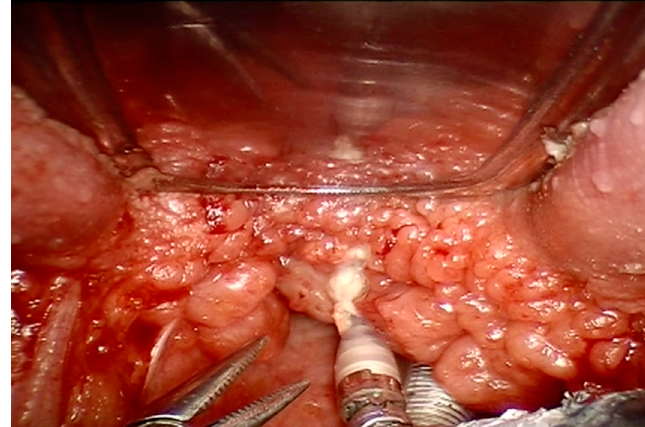
Figure 3. Transoral robotic surgery (TORS) to remove an exuberant lingual tonsil in a 12-year-old child. Courtesy of Professor C. Vicini—Department of Head-Neck Surgery, Otolaryngology, Head-Neck and Oral Surgery Unit, Morgagni Pierantoni Hospital, Forl ì , Italy.